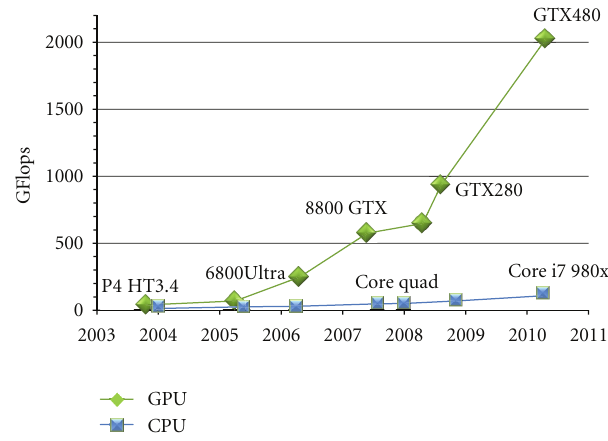
Figure 3: Computational Power: GPU versus CPU. Derived from